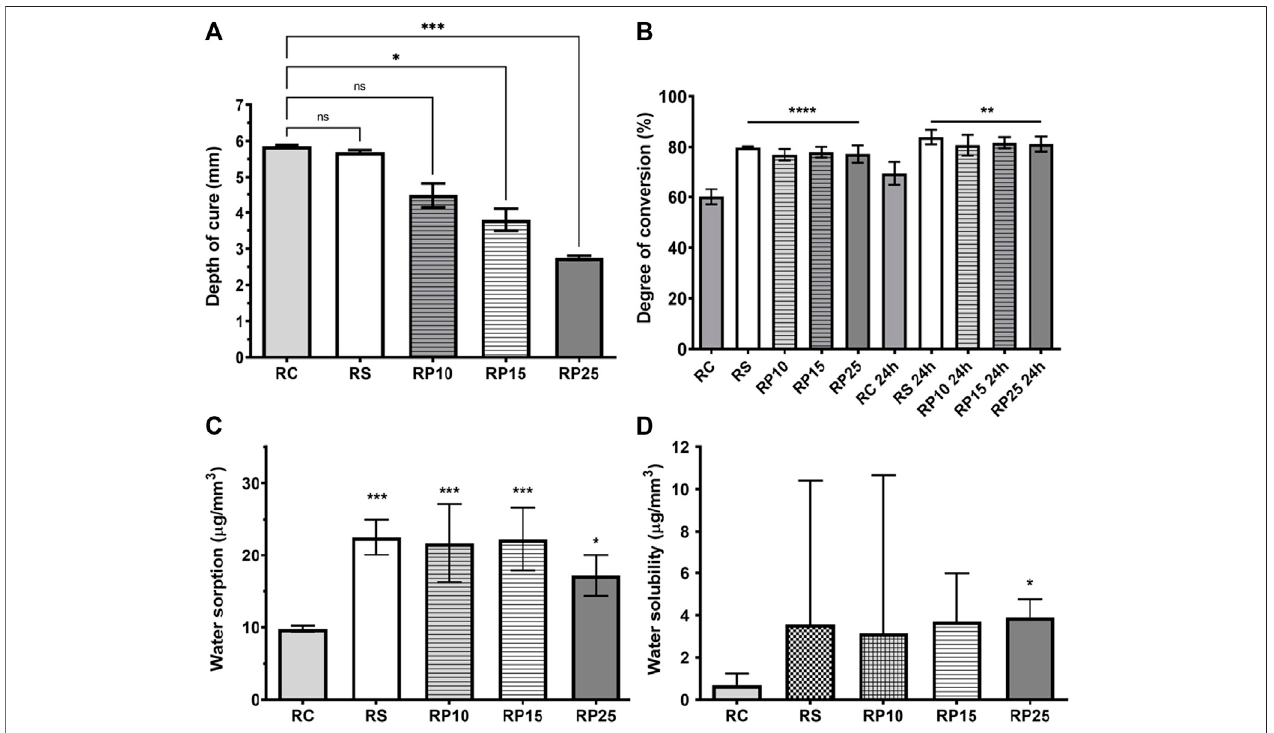
FIGURE6| Physical-chemicalcharacterizationofEABRPenrichedcompositeresins. (A) :Depthofcure. (B) :Degreeofconversion. (C) :Watersorption. (D) :Water solubility. RC, commercial resin; RS, commercial resin + HEMA solvent; RP10, RP15 and RP25, enriched EABRP composite resins at 0.10, 0.15 and 0.25% (w/w).